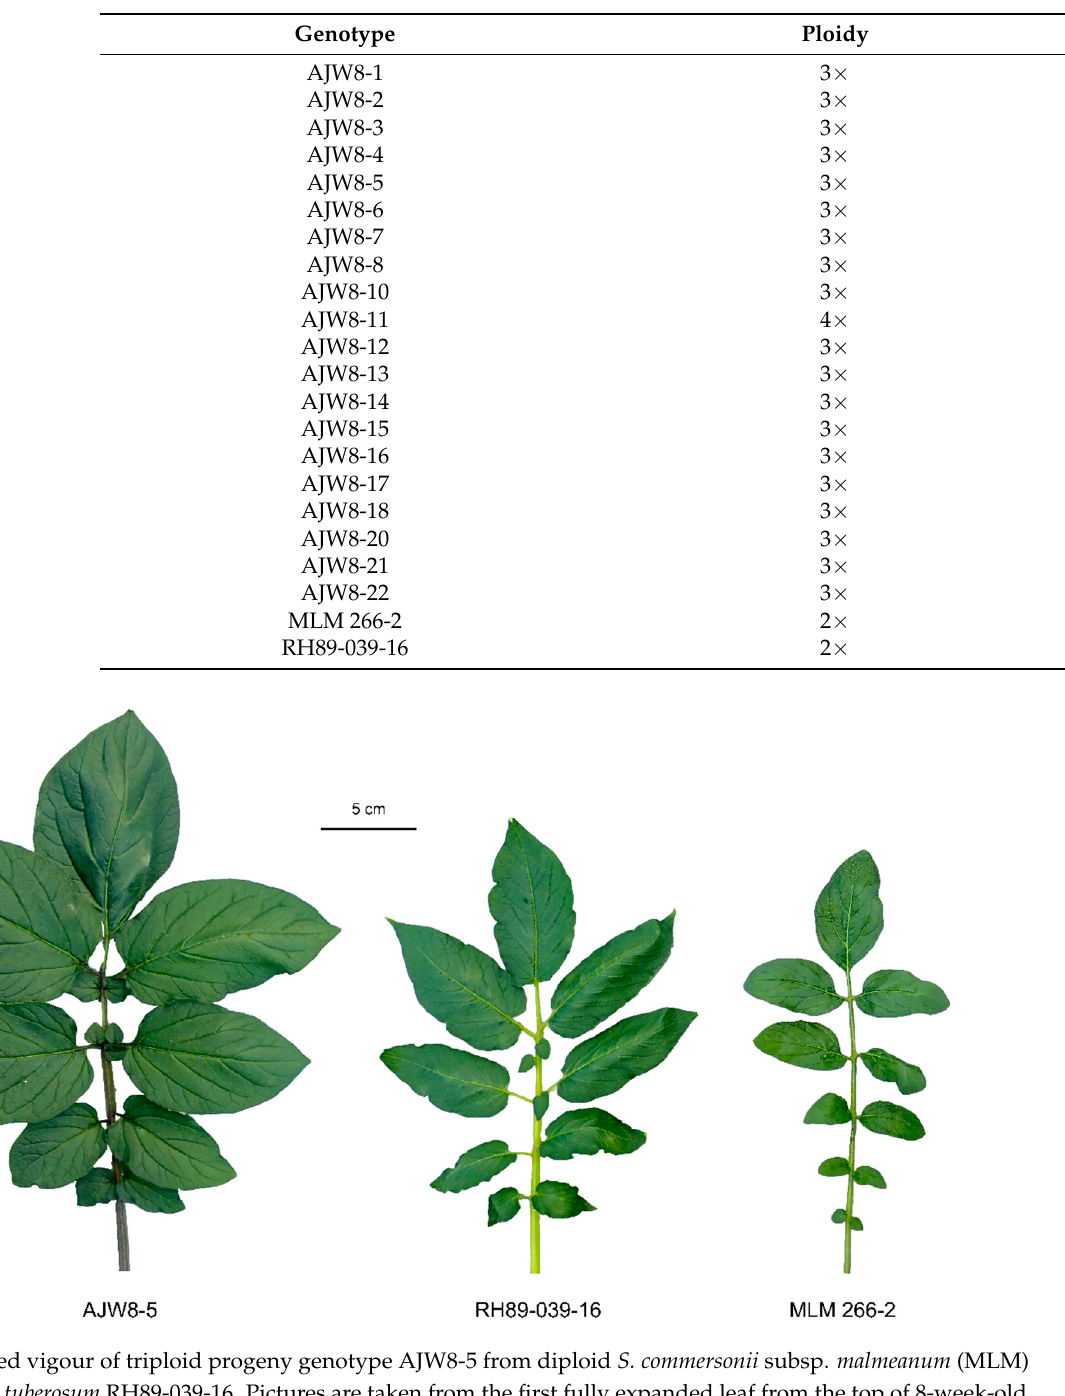
Table 3. A cross between diploid Solanum commersonii subsp. malmeanum (MLM) 266-2 and